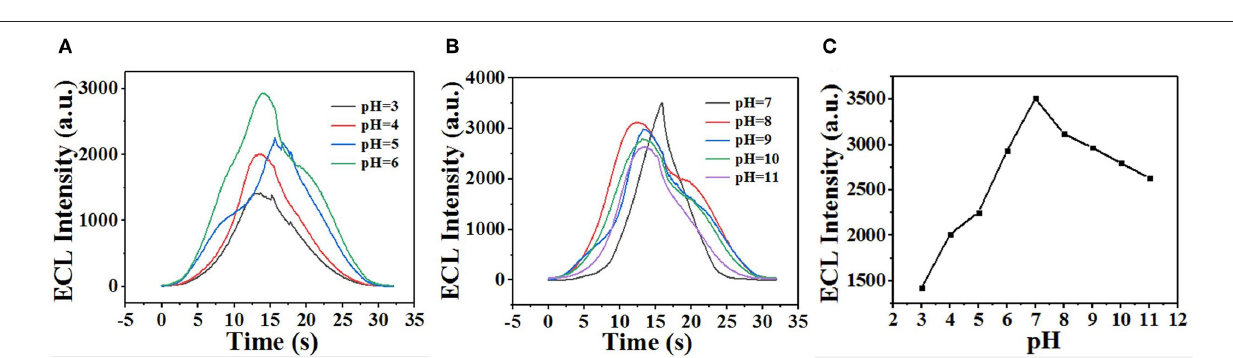
FIGURE 5 | (A,B) Effect of pH on the ECL performance. (C) ECL intensity as a function of pH.